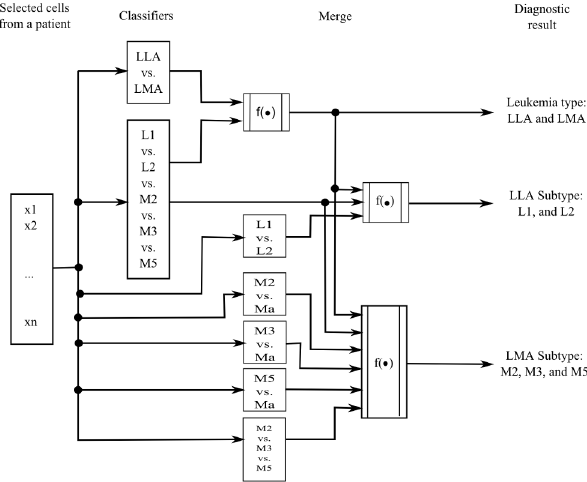
Fig 13. Classifiers fusion for the family and subtypes diagnosis of acute